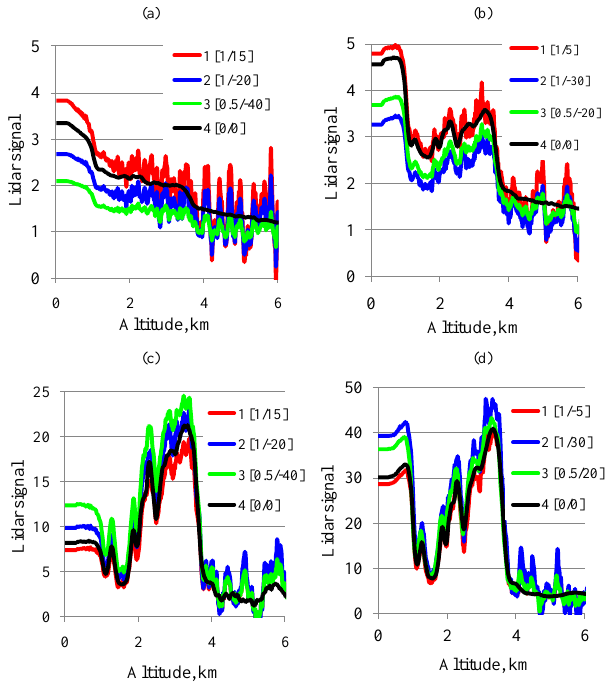
Figure 6. Range-corrected normalized lidar signals, L ∗ , corrupted with noise and amplitude distortions. Original data are provided by the München lidar team in the frame of EARLI09 intercompari- son campaign, 14:30–15:30UTC, 25 May 2009, Leipzig, Germany: (a) – 355nm, (b) 1064nm, (c) – 532nm, parallel polarized, (d) – 532nm, cross polarized; 4 – original signal, 1–3 – corrupted sig- nals. In square brackets distortion parameters α j /(cid:49) j are given.